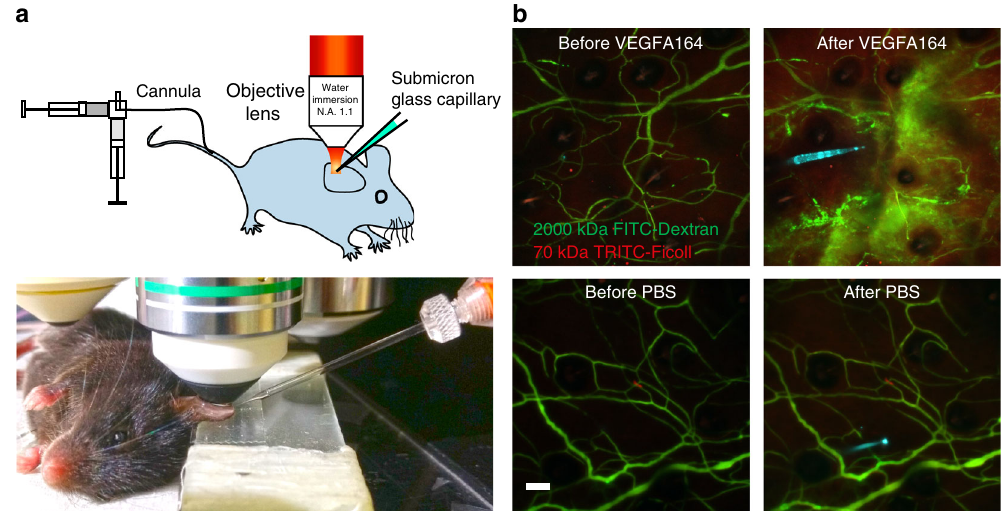
Fig. 1 Non-invasive imaging of the ear dermis vasculature. a Mice were anesthetized and immobilized to fi x the ear under a water-immersion objective lens for intravital imaging. Cannulation of the tail vein allowed administration of fl uorescent labeled dextrans or other carriers into the circulation. A sub-micron glass capillary was used for atraumatic intradermal injection. b Examples of the leakage from blood vessels in response to micro-injection of VEGFA164 but not PBS. Glass capillary was fi lled with 1 μ l VEGFA164 (1 μ g/ μ l) and Alexa633 dye (cyan); about 0.1 μ l was injected. Green, 2000kDa FITC-Dextran. Red, 70 kDa TRITC-Ficoll. Images were acquired 5 min before and 30 min after injection. Bar, 50 μ